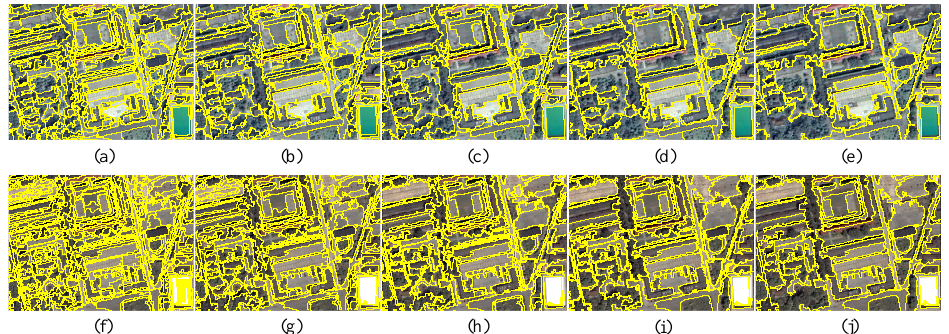
Figure 3. Subsets of segmentation maps with different scales in Experimental Area A. ( a – e ) are the scales from 100–300 in steps of 50 for the image acquired in 2004; ( f – j ) are the scales from 100–300 in steps of 50 for the image acquired in 2005.